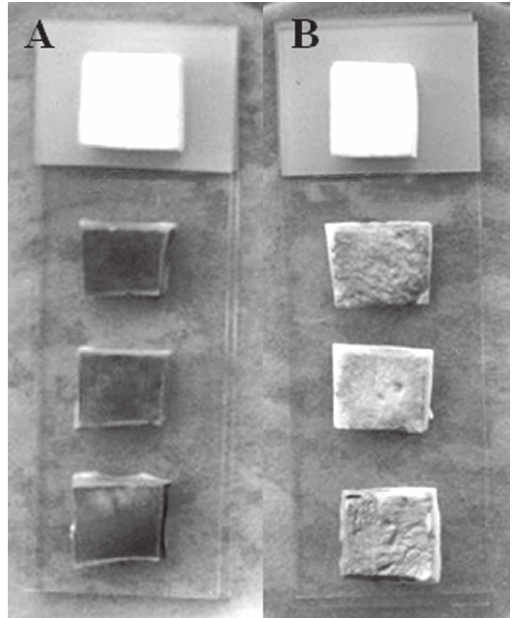
Fig. 2. Deterioration of Agaricus bisporus tissue blocks inoculated with 10 ml drops of Pseudomonas tolaasii NCPPB2192 (A) or with P. agarici USB78 (B) 10 8 cfu ml -1 suspensions. The tissue blocks in upper rows were treated with sterile distilled water.